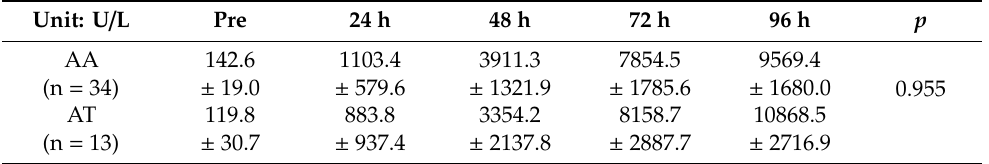
Table 4. Changes in creatine kinase (CK) after eccentric exercise according to the myostatin A55T genotype.